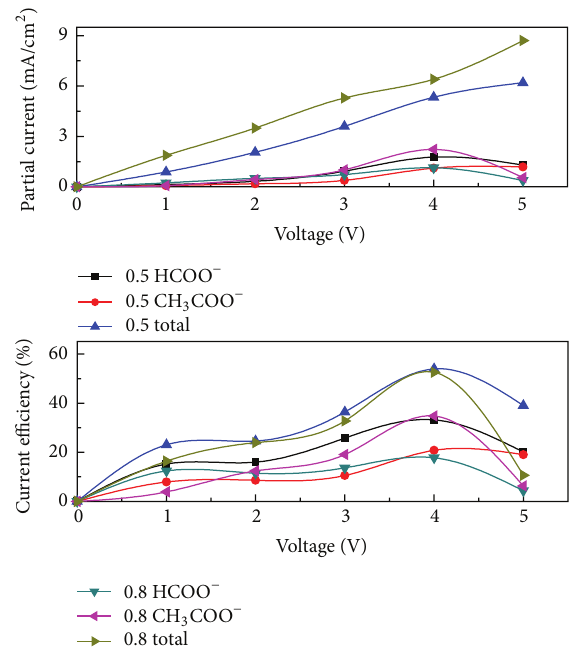
Figure 8: Variation of formic acid and acetic acid via time (4V, 0.5 mol/L and 0.8mol/L KHCO 3